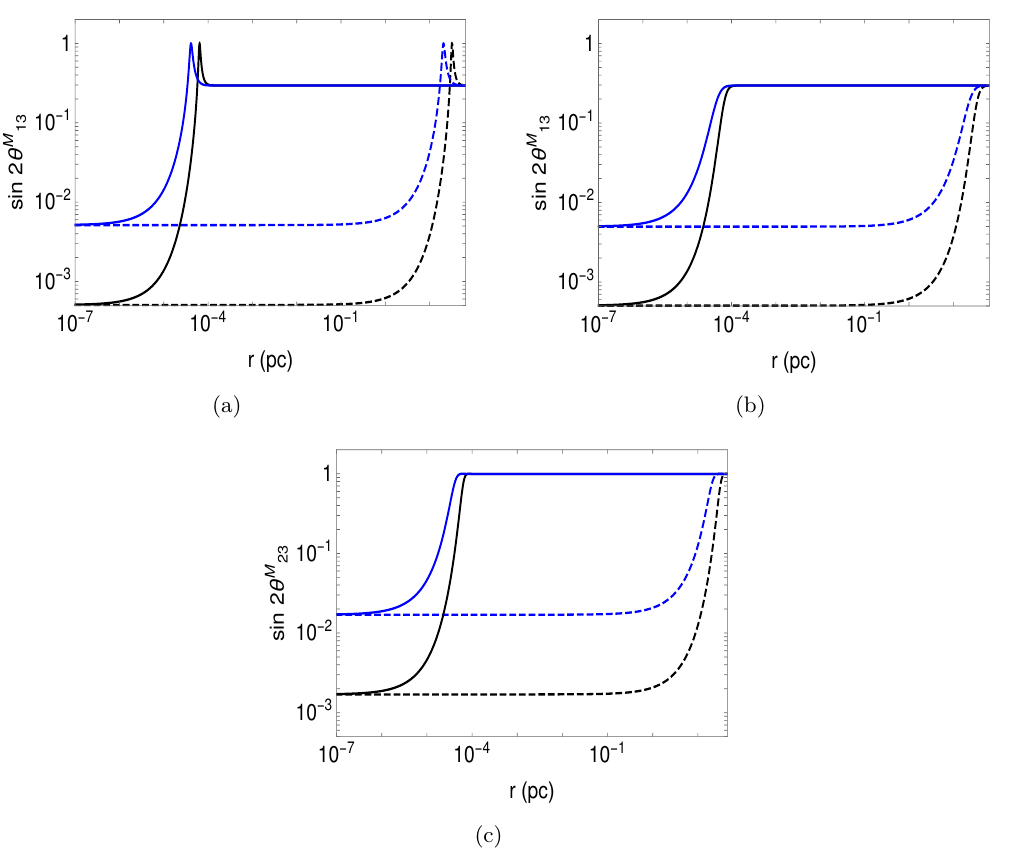
Figure 3 . Jumping probability P c brown and red lines represent P c ( i = 1 , 2) for a = 5 pc, z = 2 P c 3 i